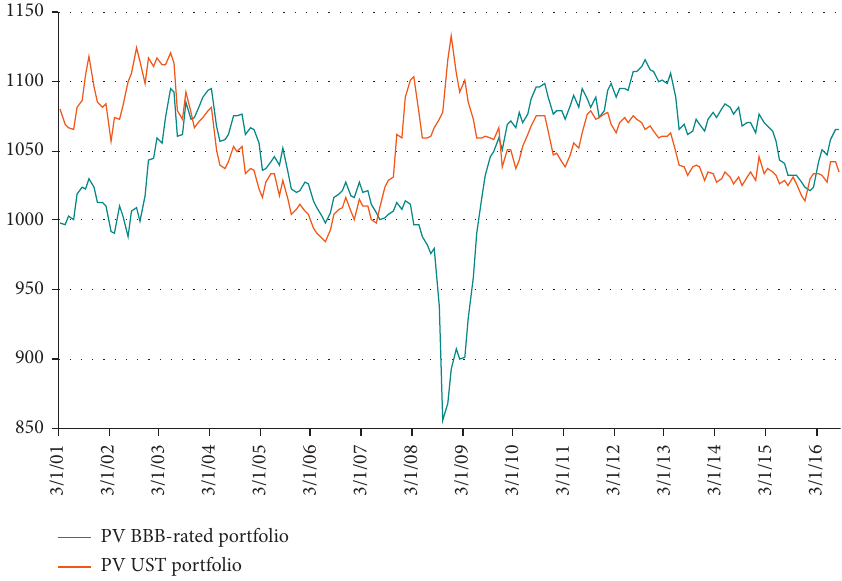
Figure 2: Present values of portfolios: US BBB-rated bonds vs. UST.